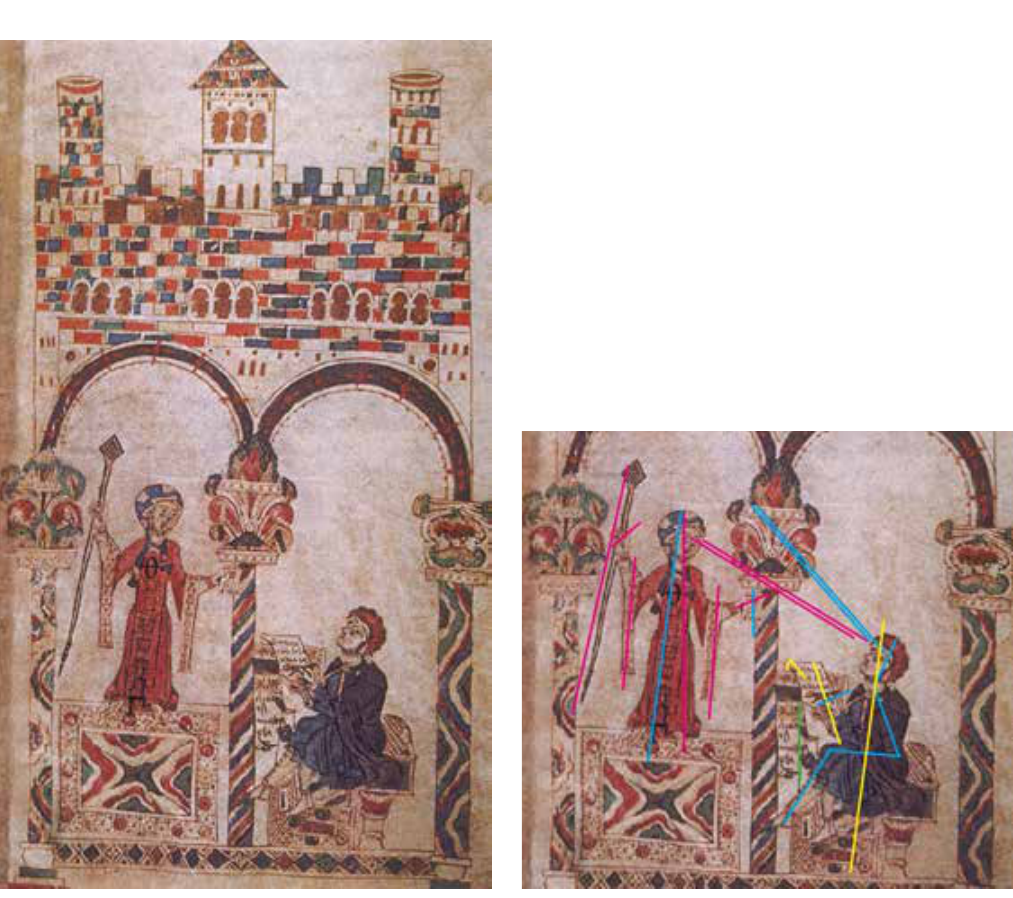
Figure 1: Anonymous, 11th/12th century. Madrid, B.N. Figure 2: Vera Kaspar, 2018. Image Finding, VK IP1: Underlining shows corresponding angles. Source: Nils